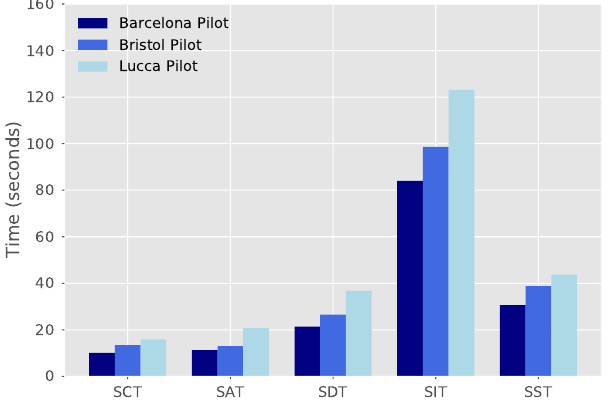
Figure 5. Deployment times of neutral host platform.